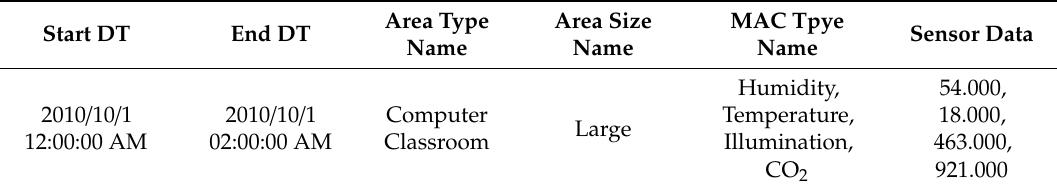
Table 1. Example-data content.